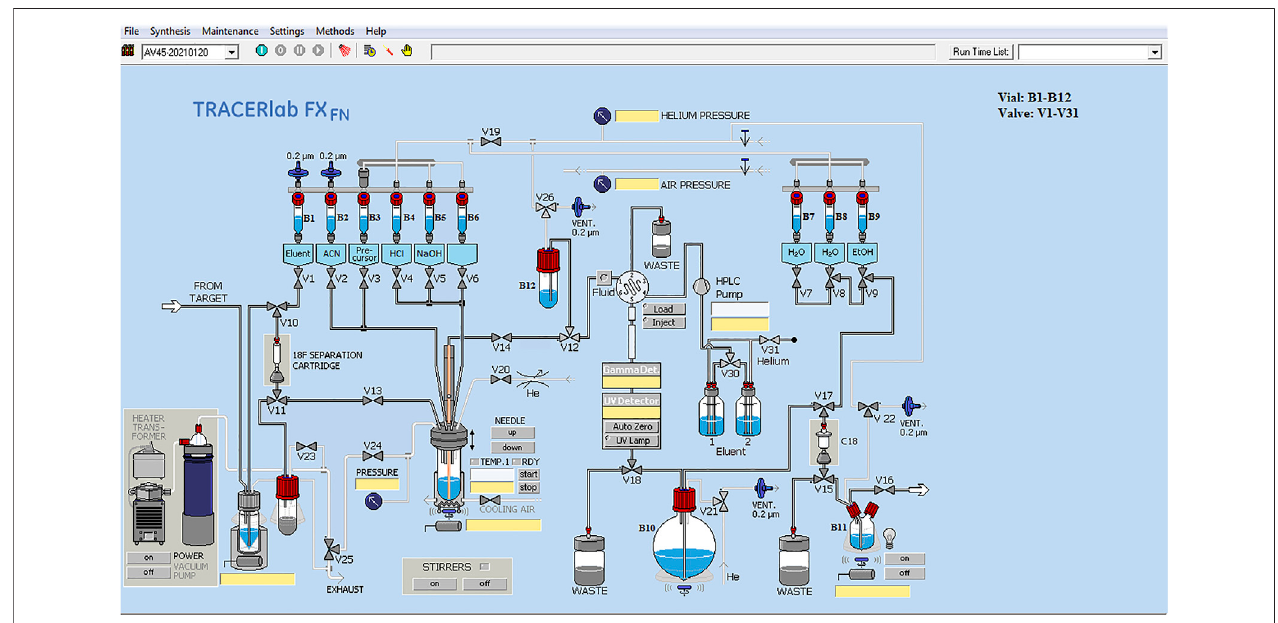
FIGURE 1 | [ 18 F] AV-45 synthesis software operation